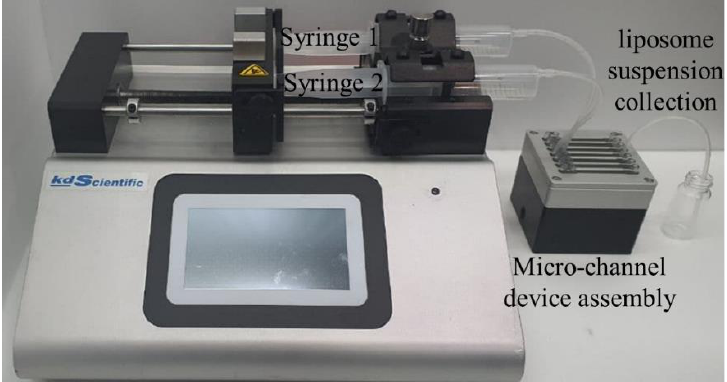
Figure 11. Experiment set-up for flow and mixing test or synthesizing liposome using micro-channel device.